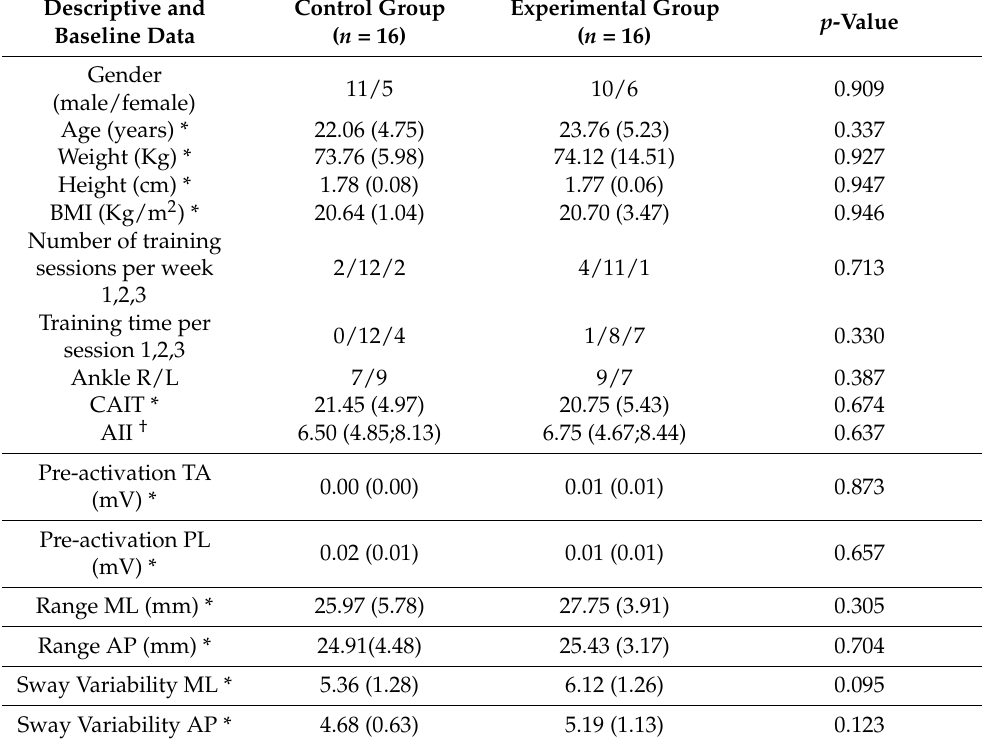
Table 2. Descriptive characteristics of the control and experimental groups. Descriptive and